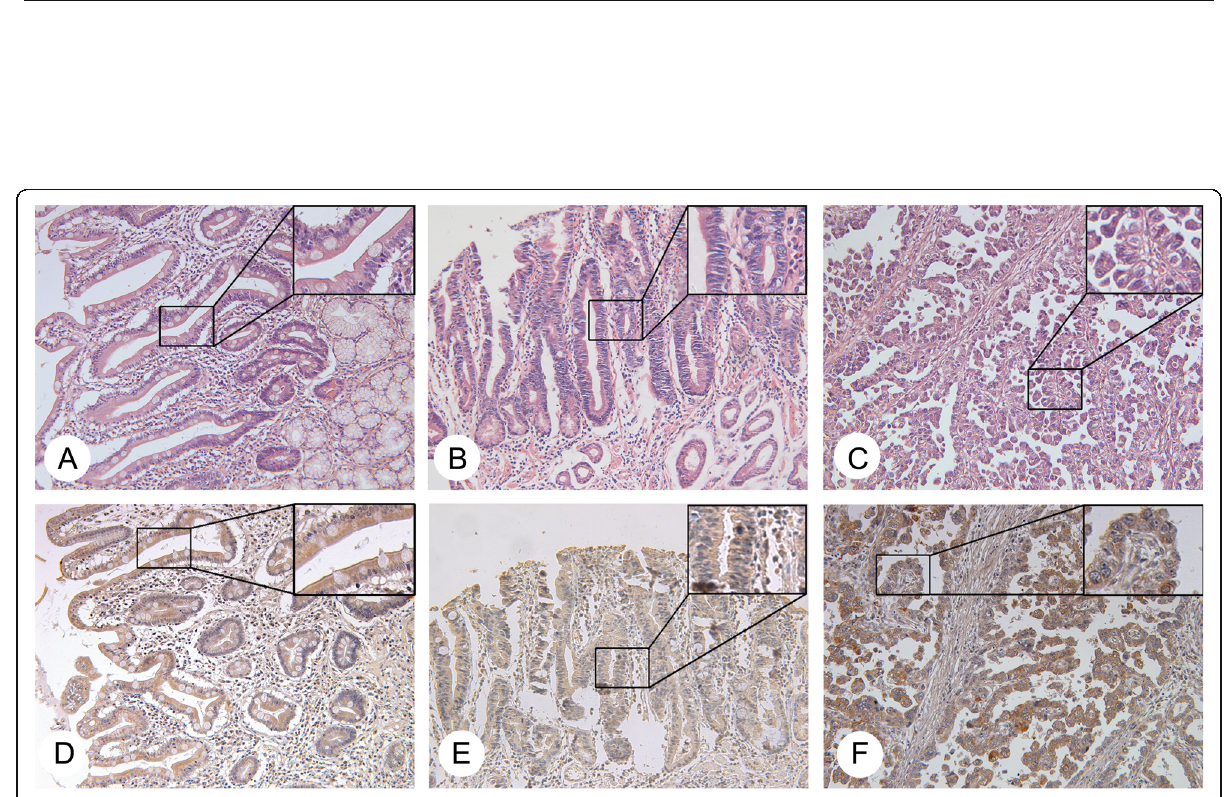
Fig. 2 GCRG213p expression in human normal gastric mucosa. Serial sections from the same block of normal gastric fundic mucosa were stained by immunohistochemistry with GCRG213p antibody (the upper row) and H&E (the lower row). a and c : GCRG213p expression in normal gastric chief cells ( a : 100×; c : 400x, IHC); e : GCRG213p was negative in surface faveolar cells (400x). b , d and f : matched gastric mucosa with H&E stain ( b : 100x; d : 400x; f : 400x)